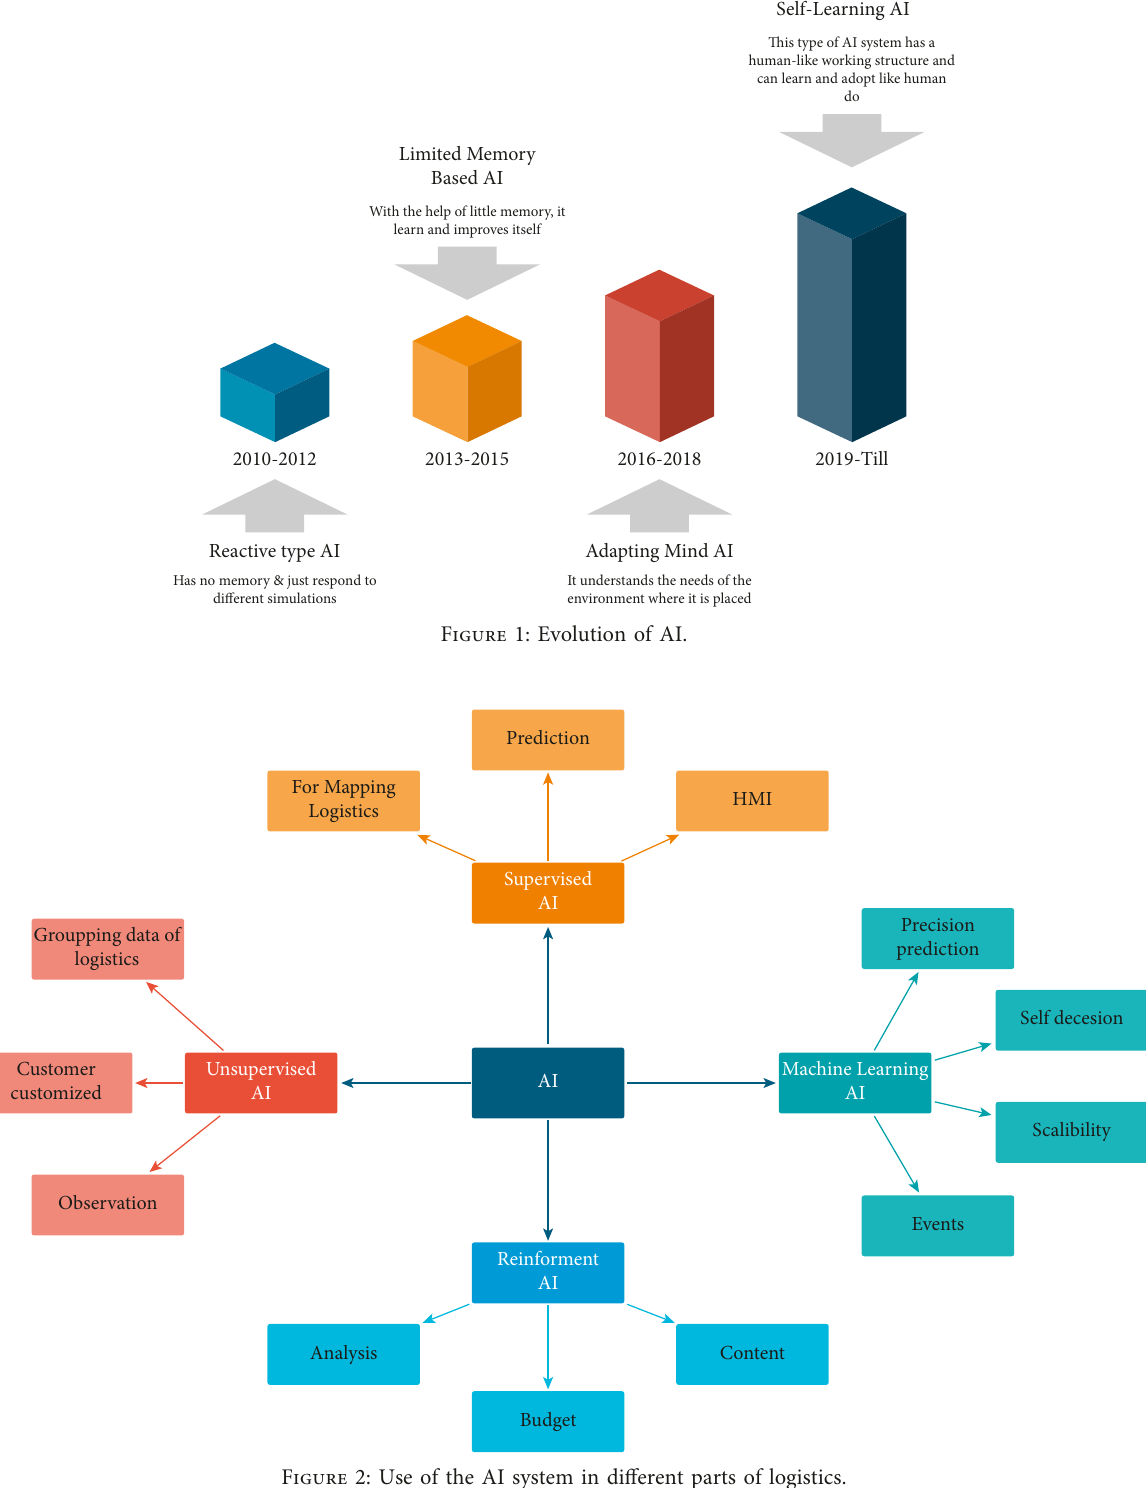
Figure 2: Use of the AI system in different parts of logistics.